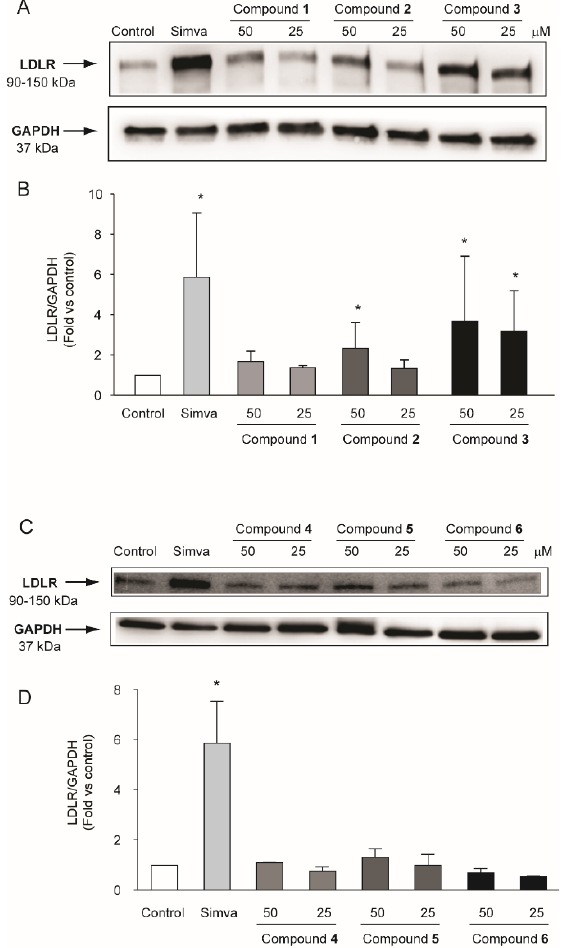
Figure 5. Effect of compounds isolated from R. michauxii on LDLR expression in the Huh7 cell line. Cells were incubated with MEM/10% FCS in the presence or absence of indicated concentrations of compounds and 2.5 µM simvastatin (simva). After 72 h, total protein extracts were prepared and LDLR expression evaluated by western blot analysis. GAPDH was used as a loading control. ( A , C ) representative images of three independent experiments. ( B , D ) densitometric readings were evaluated using ImageLab TM software. Each bar represents the mean ± SD of three independent experiments. * p < 0.05 vs. control.